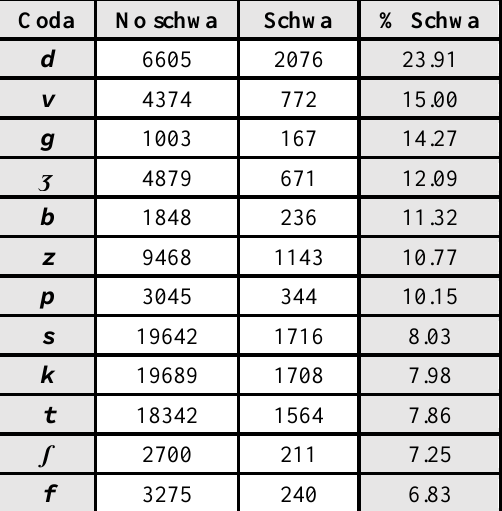
Table 4. Number of schwas after each simplex coda before pause, vowel or simplex onset (all corpora